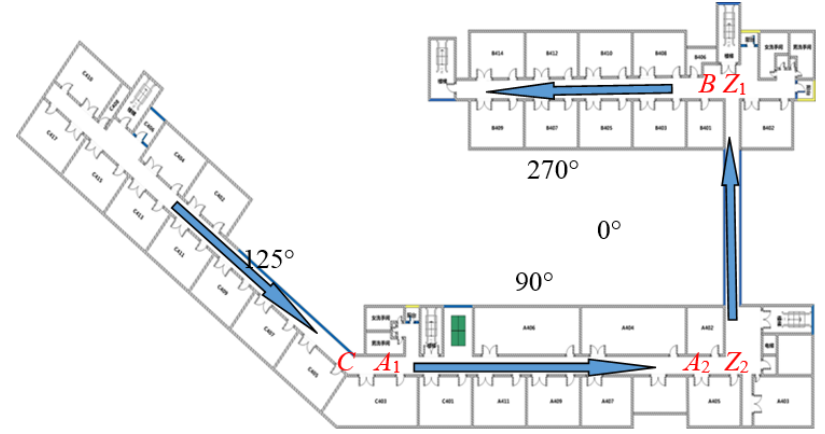
Figure 4. Analysis on the accumulated gyro value.